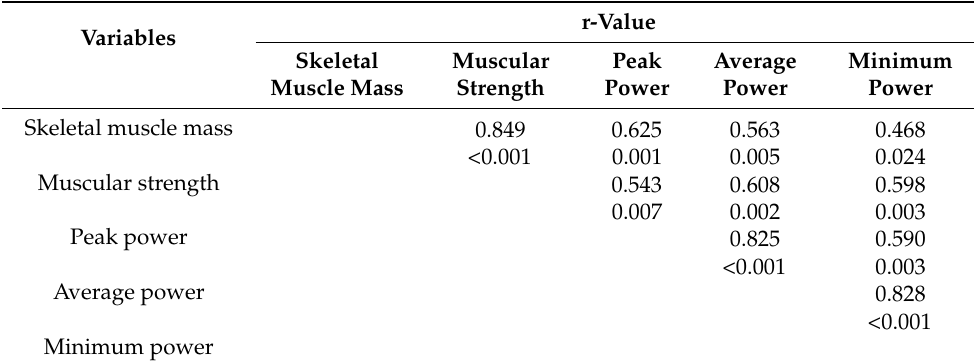
Table 3. Results of Pearson’s correlation analysis between skeletal muscle mass, muscular strength, and anaerobic